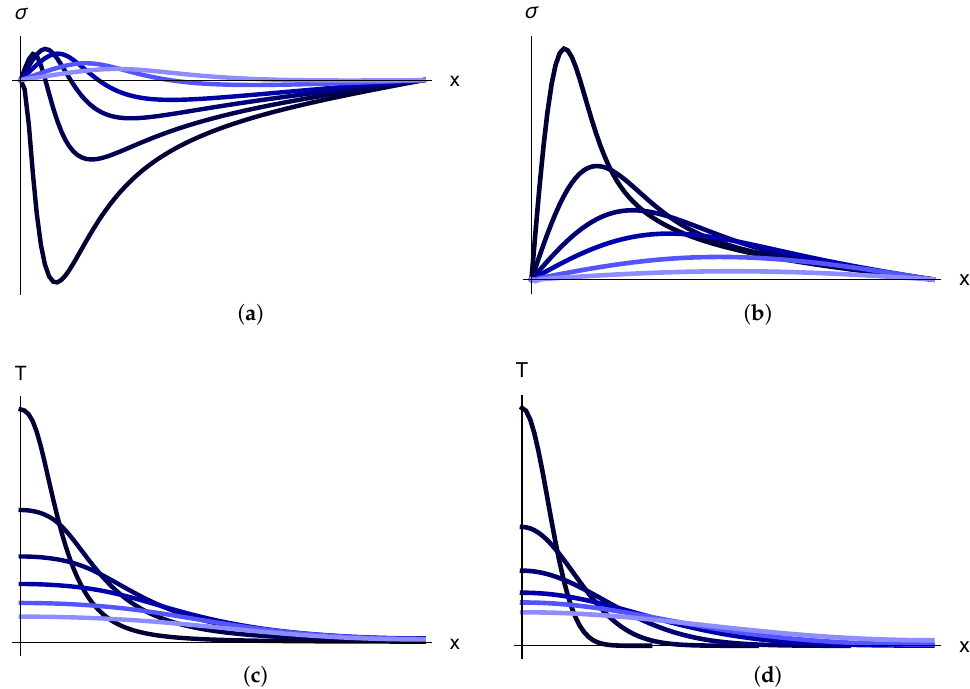
Figure 3. Evolution of stress ( a , b ) and temperature ( c , d ) fields. Colormap goes from dark to light over time. Plots ( a , c ) illustrate the solution (33), plots ( b , d ) correspond to the solution obtained within